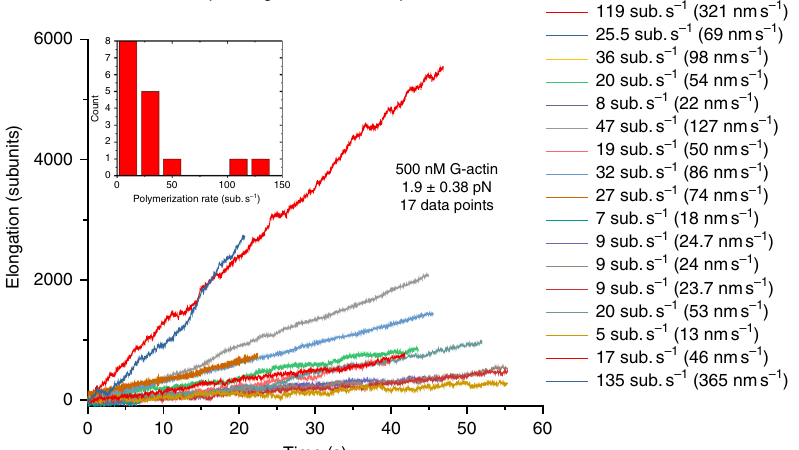
Fig. 3 The F-actin elongation rate varies depending on tether. The elongation trajectories of F-actin in 500 nM G-actin solution at 1.9 ± 0.4 pN obtained from 17 different tethers show a wide variation in speed. The inset shows the histogram of the elongation rates based on the the coverslip surface (red) or to the superparamagnetic bead (blue). Increasing force from 1.3 ± 0.3 pN to 9.2 ± 1.4 pN accel- erated actin polymerization of the force-sensitive species by sev- eral fold, and this speed reached a plateau of ~92 subunits s − 1 (250 nm s − 1 ) at forces above 6 pN.